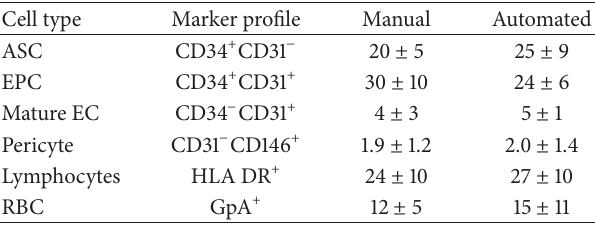
Table represents mean percentage positive cells with standard error, from four different data sets. ASC: adipose derived stem/stromal cells; EPC: endothelial progenitor cells; RBC: red blood